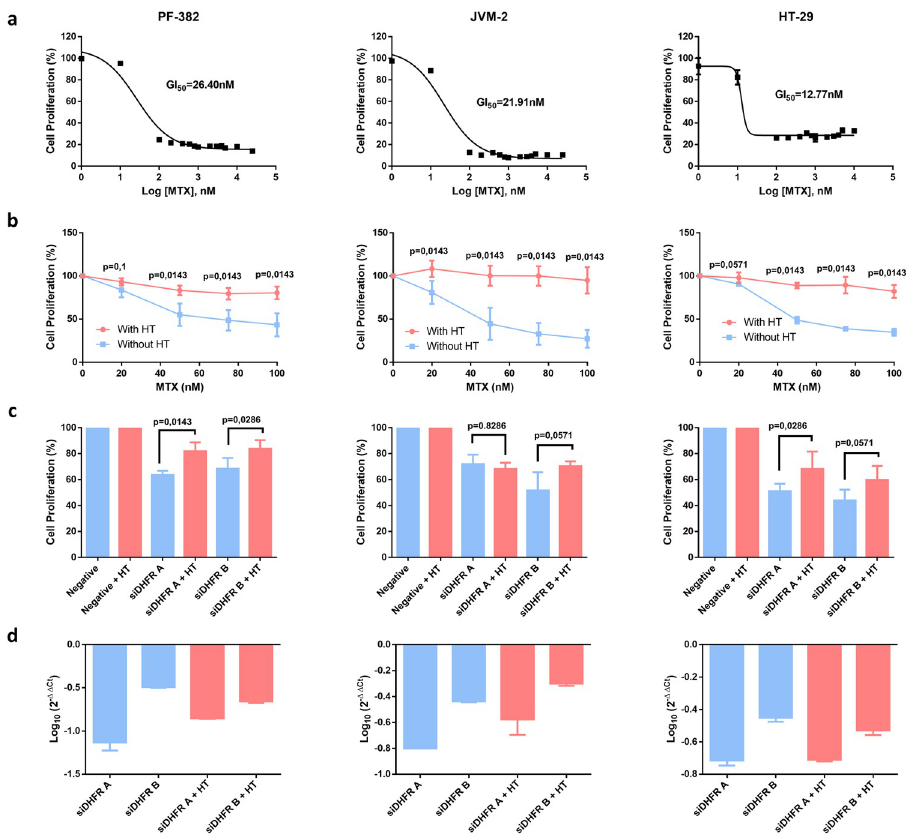
Fig 3. In-vitro experimental validation of DHFR inhibition with hypoxanthine and thymidine in the growth medium. a) GI50 values of MTX for PF-382, JVM-2 and HT-29 cell lines. b) Proliferation of PF-382, JVM-2 and HT- 29 cell lines treated with different doses of MTX for 96h in presence or absence of Hypoxanthine-Thymidine. Data represent mean ± standard deviation of four experiments. c) Proliferation of PF-382, JVM-2 and HT-29 cell lines nucleofected with siRNAs targeted to DHFR gene in presence or absence of Hypoxanthine-Thymidine was studied by MTS at day 6 after nucleofection. The proliferation percentage refers to cells nucleofected with a negative control siRNA. Data represent mean ± standard deviation of at least three experiments. d) mRNA expression of DHFR gene 48 h after nucleofection with the specific siRNAs. Data are referred to GUS gene and an experimental group nucleofected with negative control siRNA. Data represent mean ± standard deviation of four experiments. All p-values (p) were determined by one-tailed Wilcoxon tests. Abbreviations: MTX: methotrexate; HT: